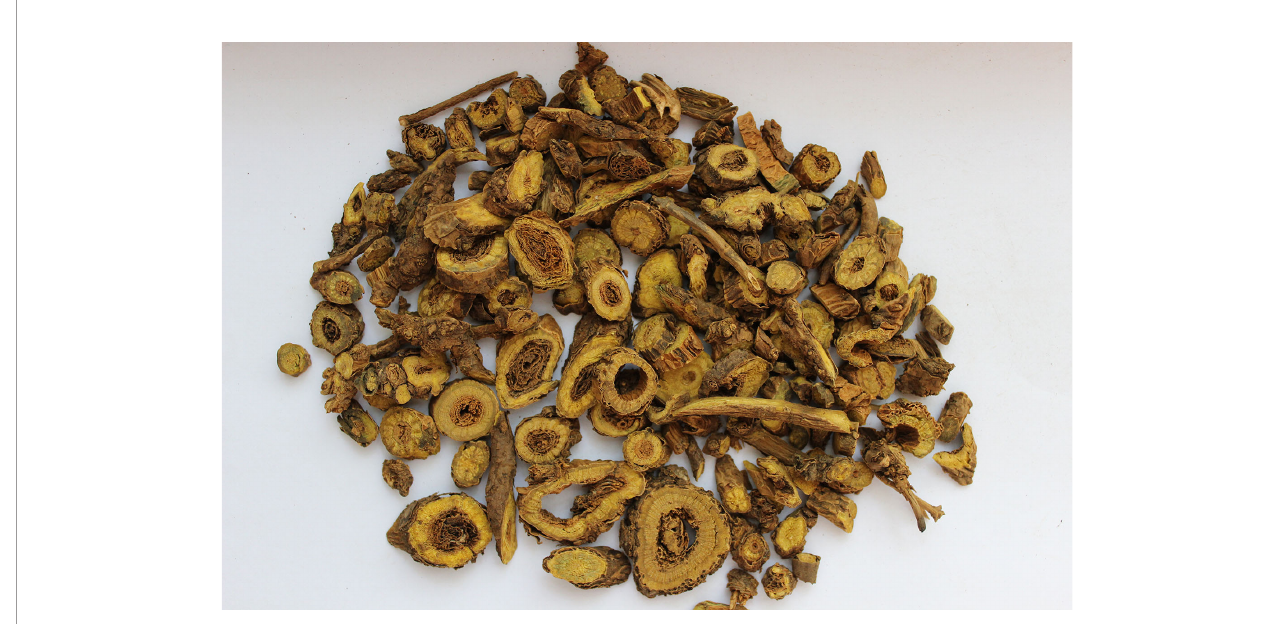
FIGURE 1 | The medicinal part of Scutellaria baicalensis Georgi and the main extraction source of